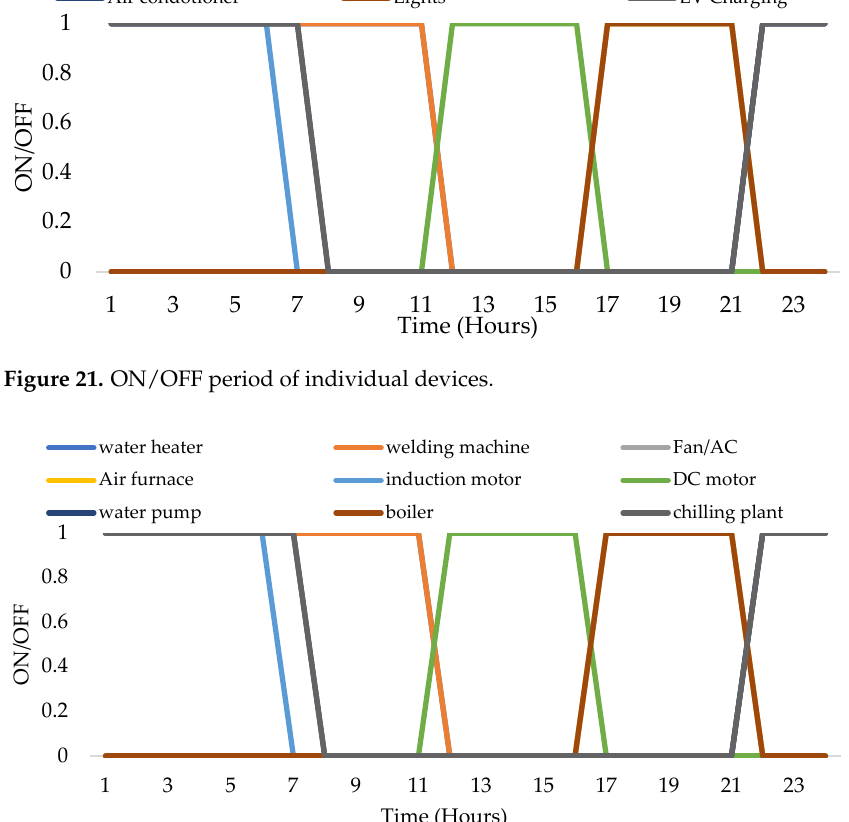
Figure 22. ON/OFF period of individual devices.